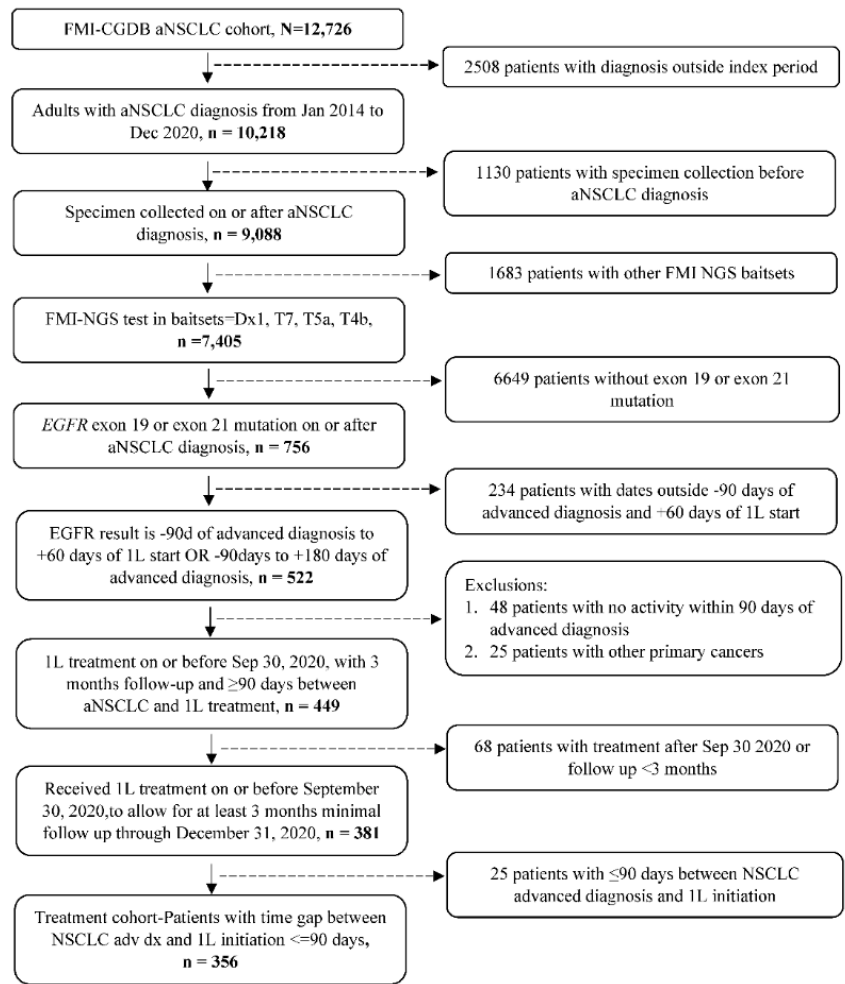
Figure 1. Patient inclusion/exclusion criteria and attrition.